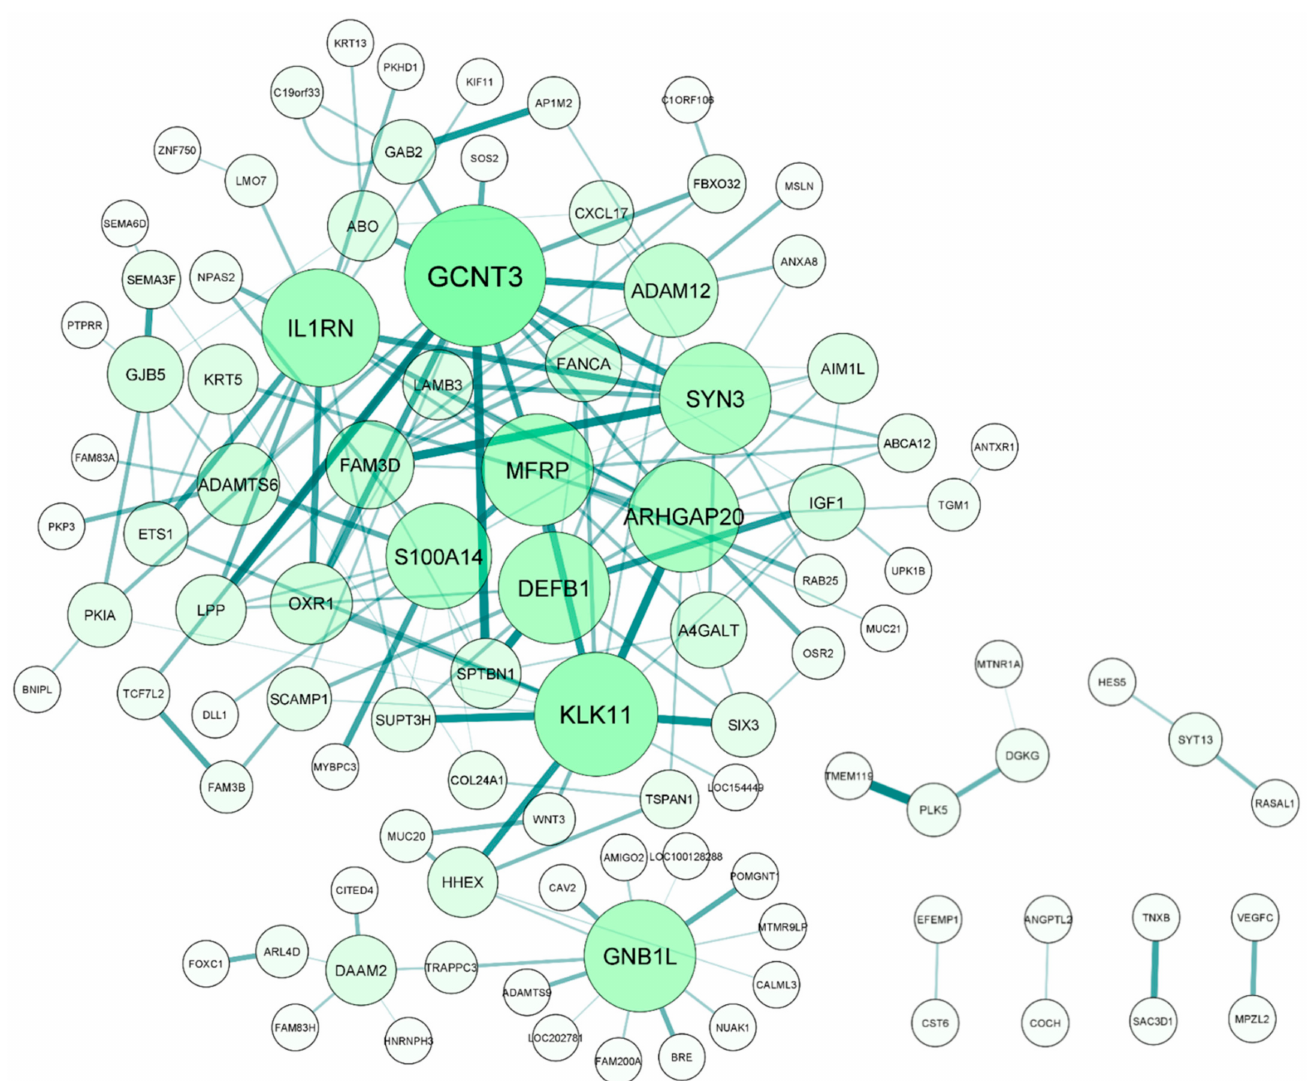
Figure 4. Complex interactions of differential correlation pairs involving intraocular pressure (IOP)-associated genes. Differential correlation analysis identified 295 differential correlation pairs (FDR ≤ 0.1) comprised of 201 genes. Of these, 166 pairs included 45 IOP-associated genes. Due to many IOP-associated genes being a part of multiple differential correlation pairs, these gene pairs formed several complex correlation networks. The size and color of the nodes indicate which genes are involved in the most differential correlation pairs with the larger green nodes having the most interactions. Similarly, the size and color of the lines connecting the gene nodes indicate the significance of the differential correlation with thicker, darker lines representing greater